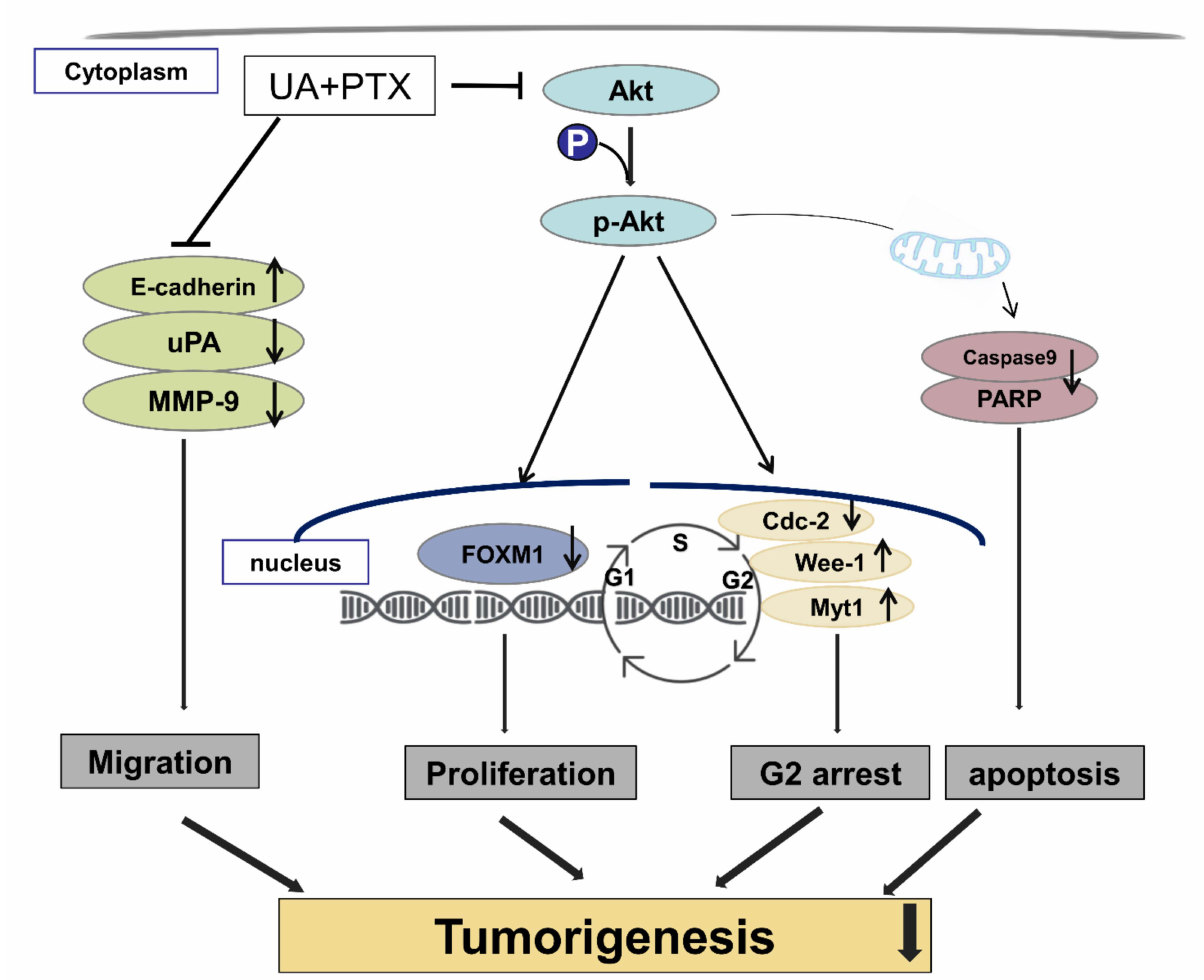
Figure 10. Schematic diagram represents that UA enhances PTX induced cell death in ESCC cells by inactivating Akt/Foxm1 signaling